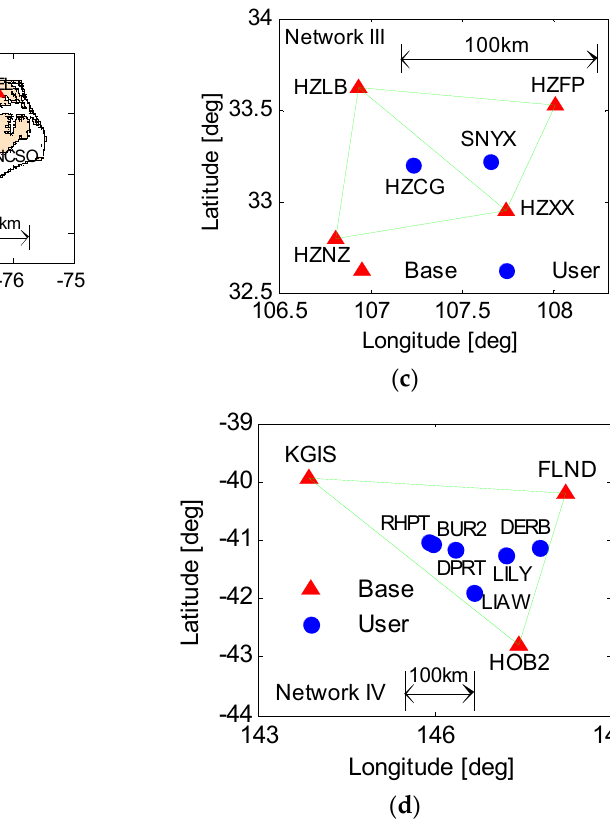
Figure 3. Four groups of reference network distributions with different inter-station distances: ( a ) network I located in North Carolina, USA, with GPS/Galileo dual-frequency data; ( b ) network II located in California, USA, with GPS/Galileo triple-frequency data; ( c ) network III located in Shaanxi, China, with GPS/Galileo/BDS-2/BDS-3 quad-frequency data; and ( d ) network IV located in Hobart, Australia, with GPS/Galileo/BDS-2/BDS-3 quad-frequency data. Table 2. Detailed information of the four sets of reference network data.